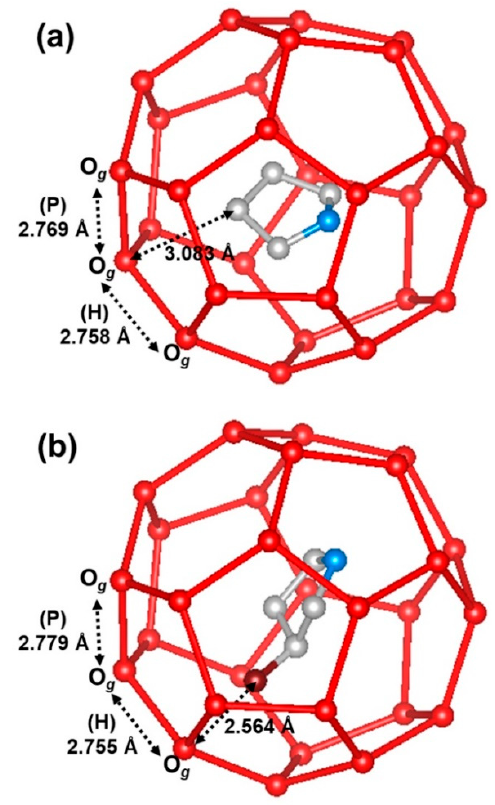
Figure 3. Guest distributions with full symmetry in 5 12 6 4 and 5 12 cages. ( a ) THF + O 2 and ( b ) 3-OH THF + O 2 hydrates. (Red: oxygen of O 2 molecule; Gray: carbon; blue: oxygen in cyclic rings; brown: oxygen of hydroxyl group. Hydrogen atoms are omitted.).